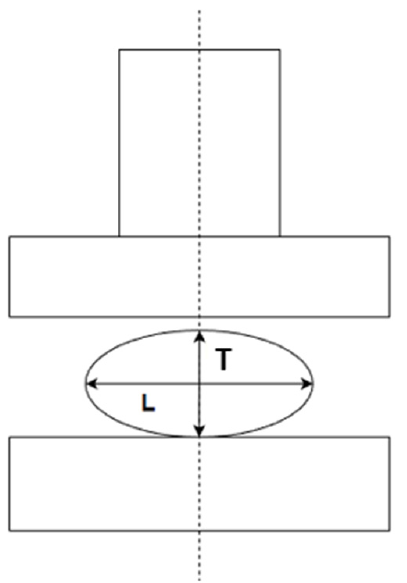
Figure 2. Grain position between parallel plates: length (L), thickness (T).